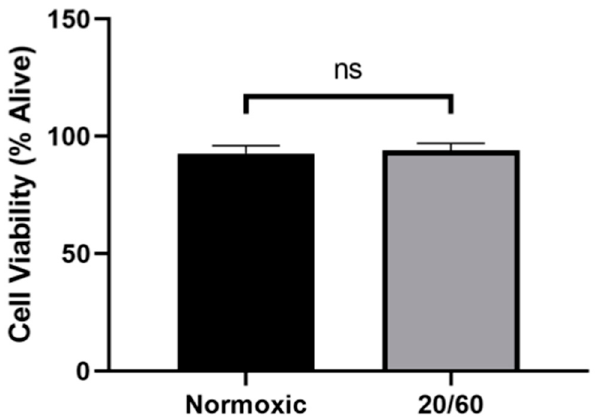
Figure 1. Oxygen-glucose deprivation/reperfusion (OGD/R) does not alter the viability of U251-MG cells. U251-MG cells underwent OGD for 20 min, followed by reperfusion for 60 min. There was no significant difference between the viability of normoxic control U251-MG cells and OGD/R-treated U251-MG cells (n = 3; unpaired student t -test). ns denotes no significance.